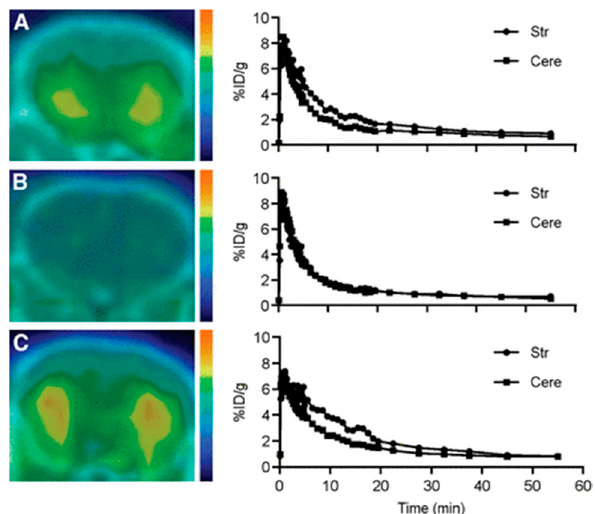
Figure 7. PET/CT images and time-activity curves of 21 for striatum and cerebellar cortex of ( A ) α 2A KO ( B ) α 2AC KO and ( C ) WT mice. Brain uptake of 21 in α 2AC KO is negligible and is similar in α 2A KO and WT mice with 7.8–8.1% ID/g at 1 min and 1.2% ID/g at 30 min after 21 injection. The striatum to cerebellar cortex radioactivity ratios (at 5–15 min) for α 2AC KO mice did not differ and for α 2A KO and WT mice are alike. Adapted from JNM publication by Arponen E.; Helin, S.; Marjamäki, P.; Grönroos, T.; Holm, P.; Löyttyniemi, E.; Någren, K.; Scheinin, M.; Haaparanta-Solin, M.; Sallinen, J.; [36]. Permission obtained from SNMMI.